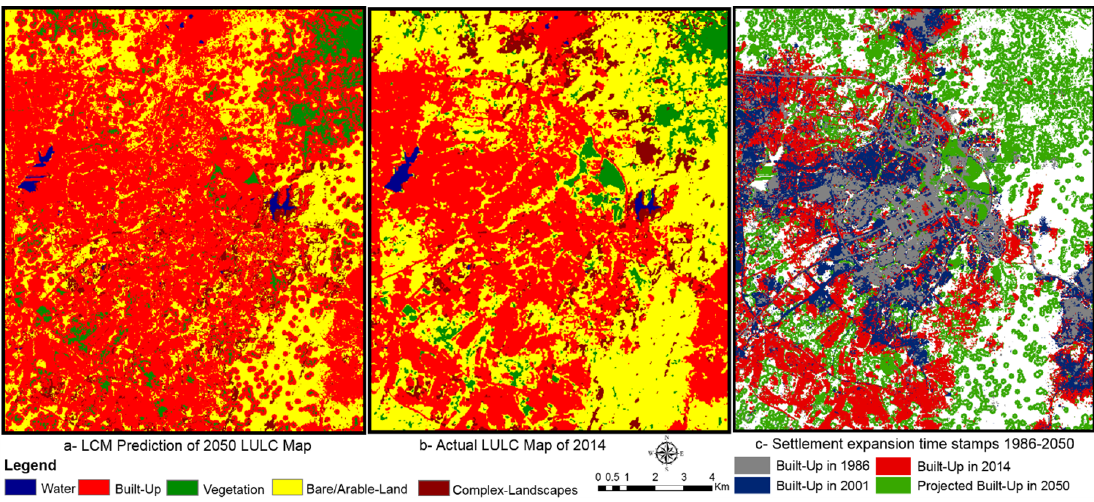
Figure 8. ( a ) Simulated LCM-based LULC map in 2050; ( b ) Actual 2014 LULC map; ( c ) Time stamps of built-up area from 1986 to 2050 projection scenario.